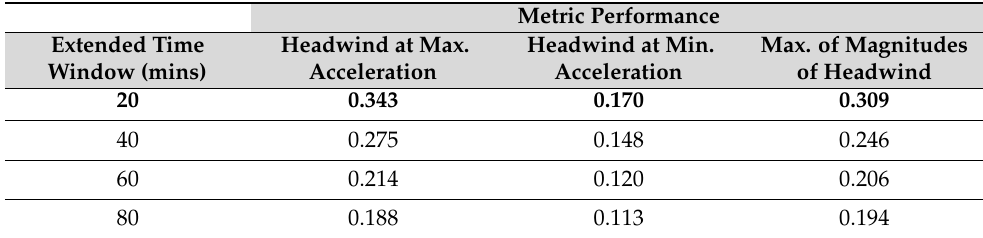
Table 8. Sensitivity of the quantitative indicator of performance (better performance indicated in bold with +1 indicative of ideal performance) to the extended wind-shear time window. 07RA runway corridor, typical met, horizontal acceleration, half runway